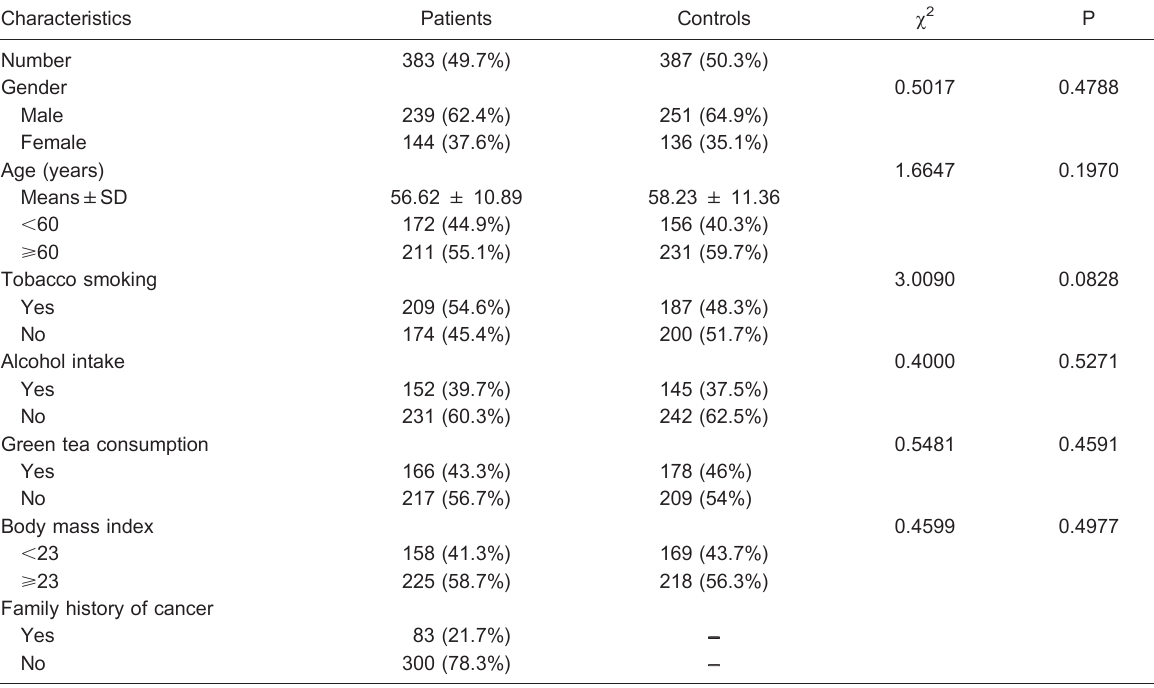
Table 1. General characteristics of patients with esophageal cancer and cancer-free controls.